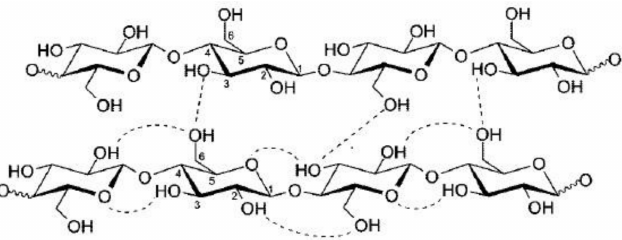
Figure 2. Intra- and intermolecular hydrogen bonds in cellulose (adapted with permission from [39]).